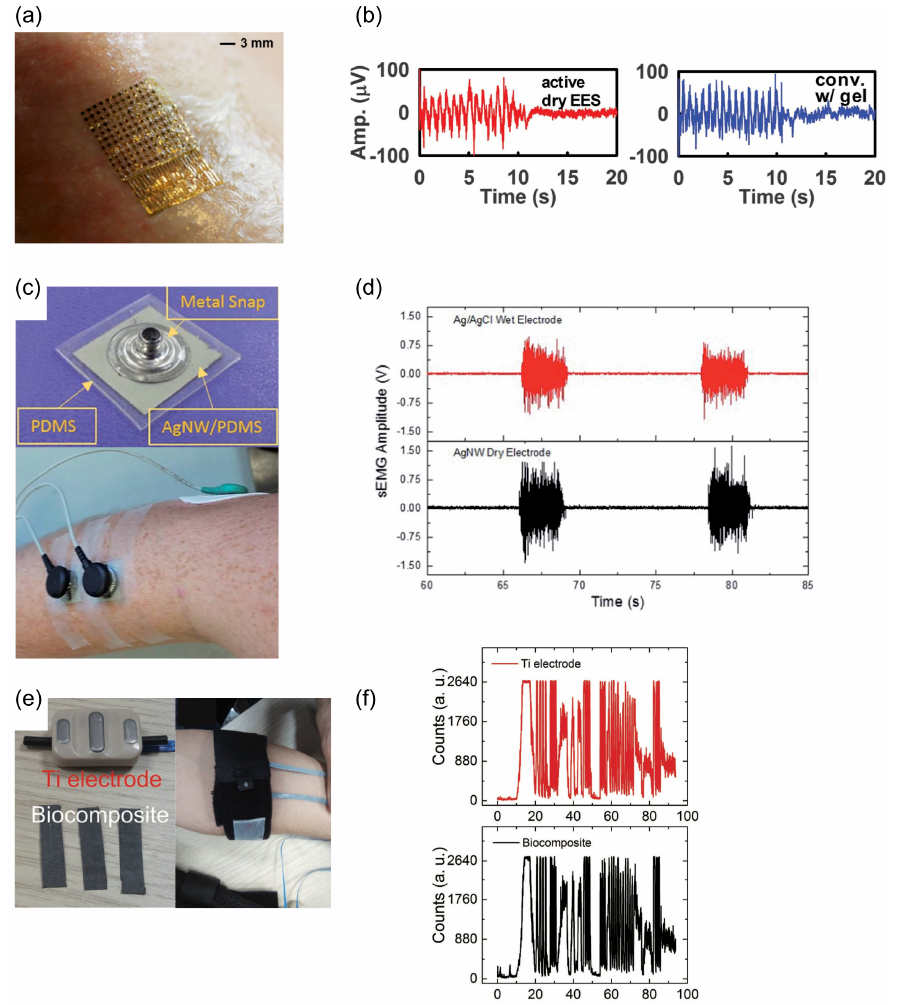
Figure 7. Wearable sensors for electromyography (EMG) monitoring: ( a ) image of an epidermal